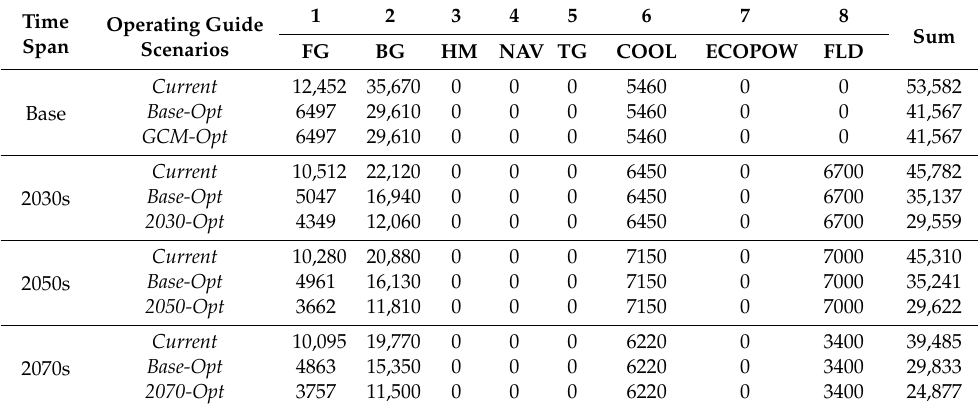
Table 3. Comparison of individual cumulative penalties for different time